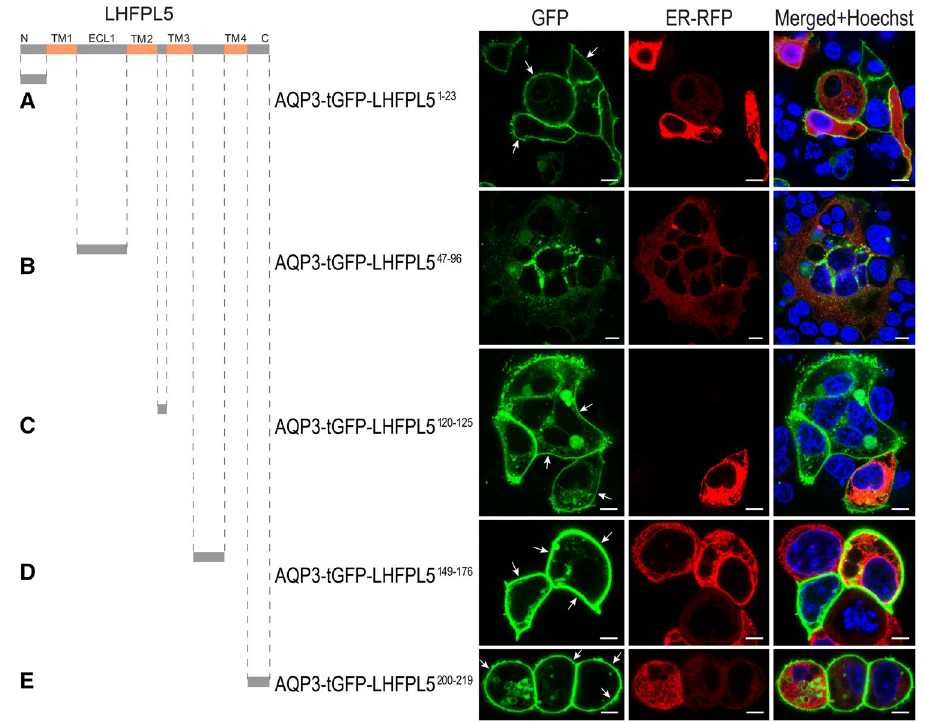
Figure 1. AGR discerns the ability of LHFPL5 regions to halt trafficking to the PM. AGR-based method was used to examine whether any of intracellular and extracellular loops, as well as N- and C-termini of LHFPL5 have the ability to preclude any detectable reporter trafficking to the PM. ( A ) The N-terminus fragment of LHFPL5, comprising residues LHFPL5 1–23 , does not preclude trafficking of the AGR system to the PM. When expressed in HEK293 cells, AQP3-tGFP-LHFPL5 1–23 exhibit robust PM localization (white arrows). ( B ) In contrast, extracellular loop 1, consisting of LHFPL5 47–96 fragment, halts any detectable trafficking to the PM. AQP3-tGFP-LHFPL5 1–23 expression shows an intracellular only labeling pattern. ( C–E ) AGR-based constructs containing the remaining intracellular loop 1, LHFPL5 120–125 ( C ), extracellular loop 2, LHFPL5 149–176 ( D ) or the C-terminus, LHFPL5 200–219 ( E ) show PM labeling. Scale bars: 10 µm. ER was labeled with ER-red fluorescent protein (ER-RFP) in all